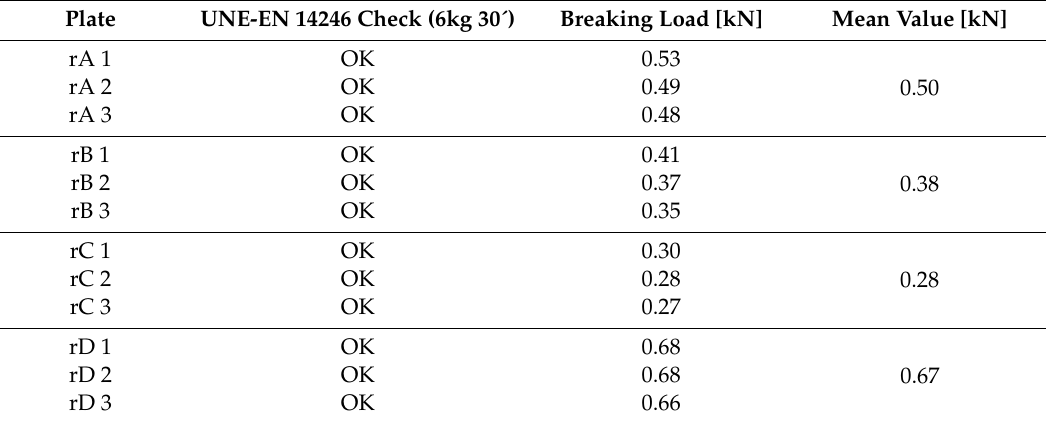
Table 8. Flexural strength test results for the Scenario 2 plates.